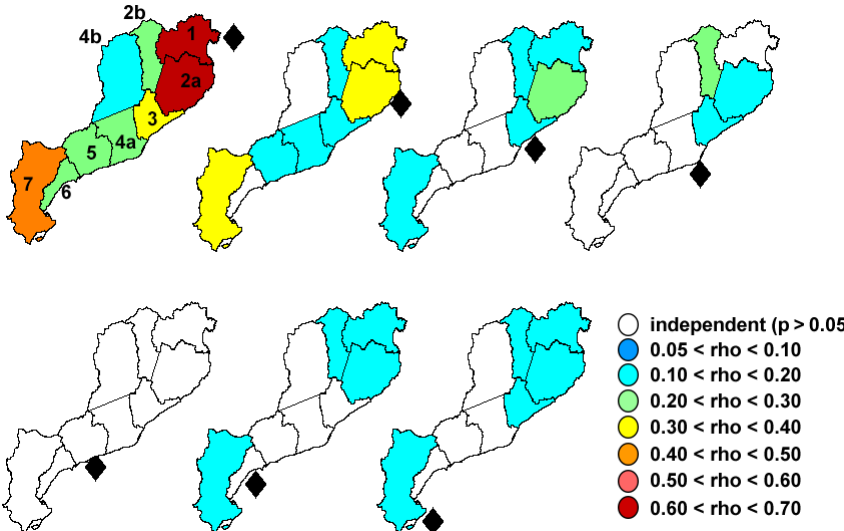
Figure 7. Correlation values (Spearman ρ ) between the H s magnitude and P24h during compound events. Each map shows the correlation between the waves ( H s ) in the area indicated by the diamond and rainfall in the other areas. White areas indicate that variables are statistically independent at a significance level of 0.05. Area numbers are specified on the top left